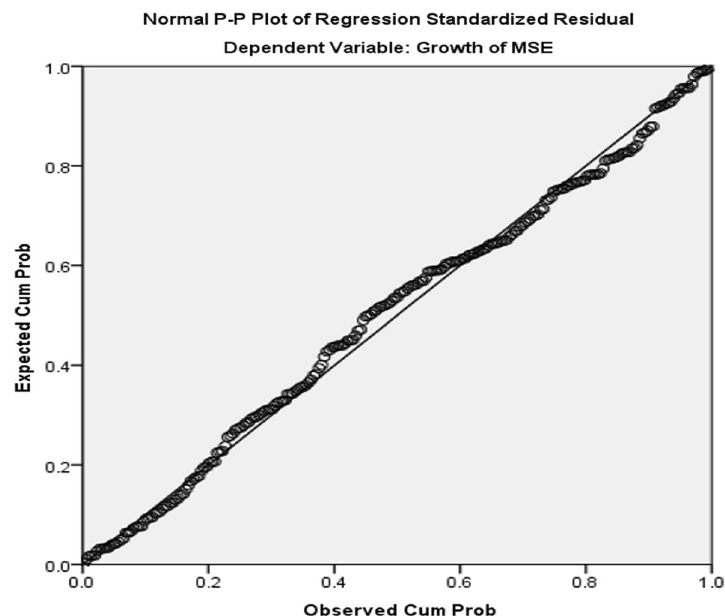
Fig. 3 P–P plot. Source: Survey,